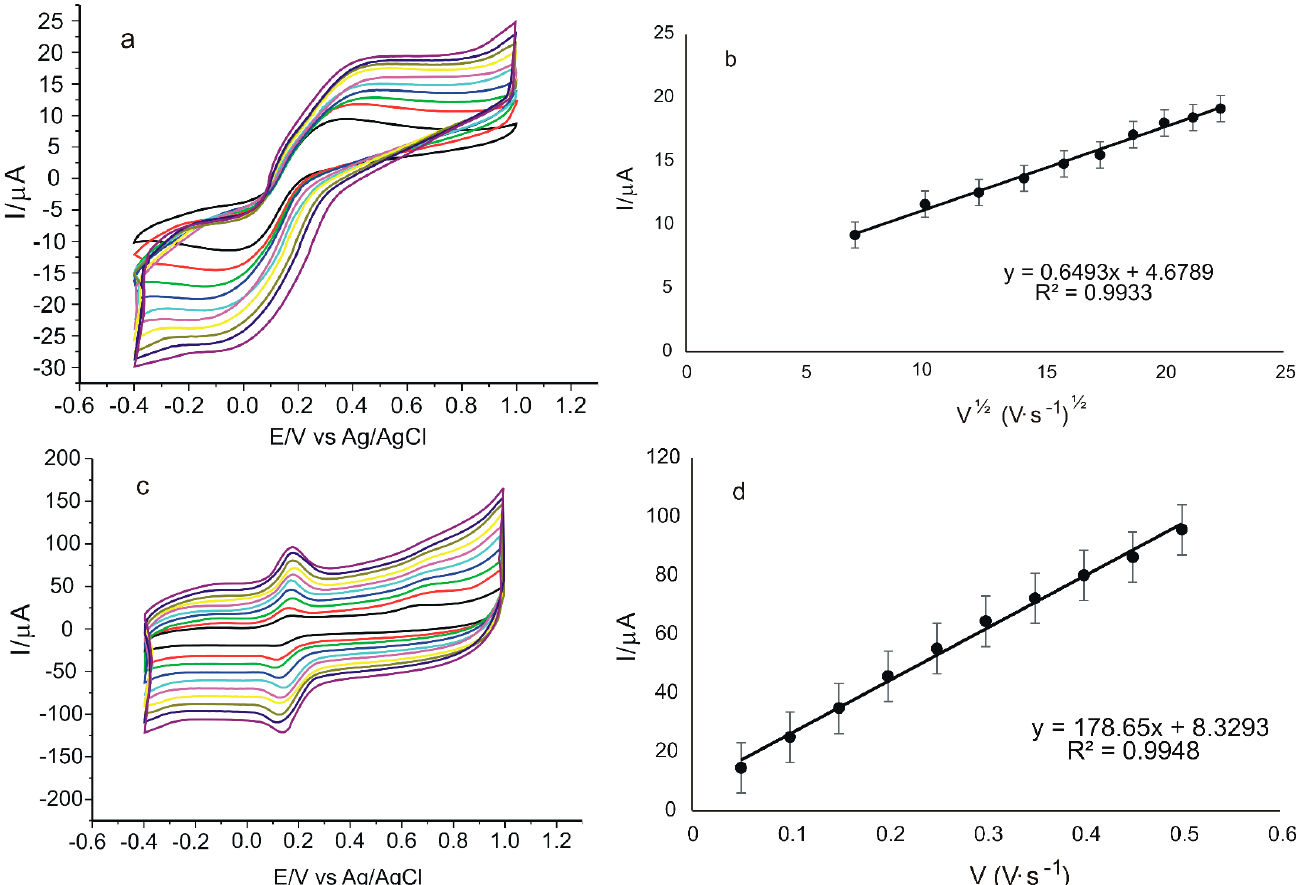
Figure 9. Cyclic voltammograms of GO/SPCE ( a ) and GO-Peptide/SPCE ( c ) immersed in 10 − 3 M K 4 [Fe(CN) 6 ]/K 3 [Fe(CN) 6 ]–PBS 0.1 M solution at pH = 6.5 recorded at scan rates between 0.05 and 0.5 V·s − 1 . Linear dependence of Ipa and square root of scan rate in the case of GO/SPCE ( b ) and linear dependence of Ipa and scan rate in the case of GO-Peptide/SPCE ( d ).